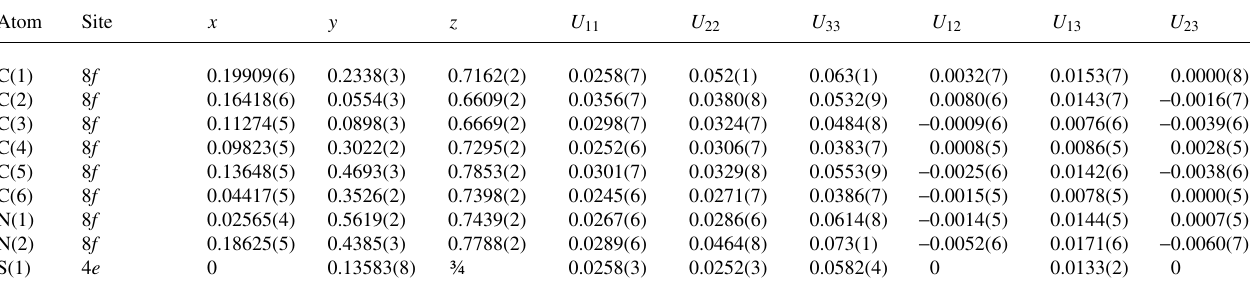
Table 3. Atomic coordinates and displacement parameters (in Å 2 ) .